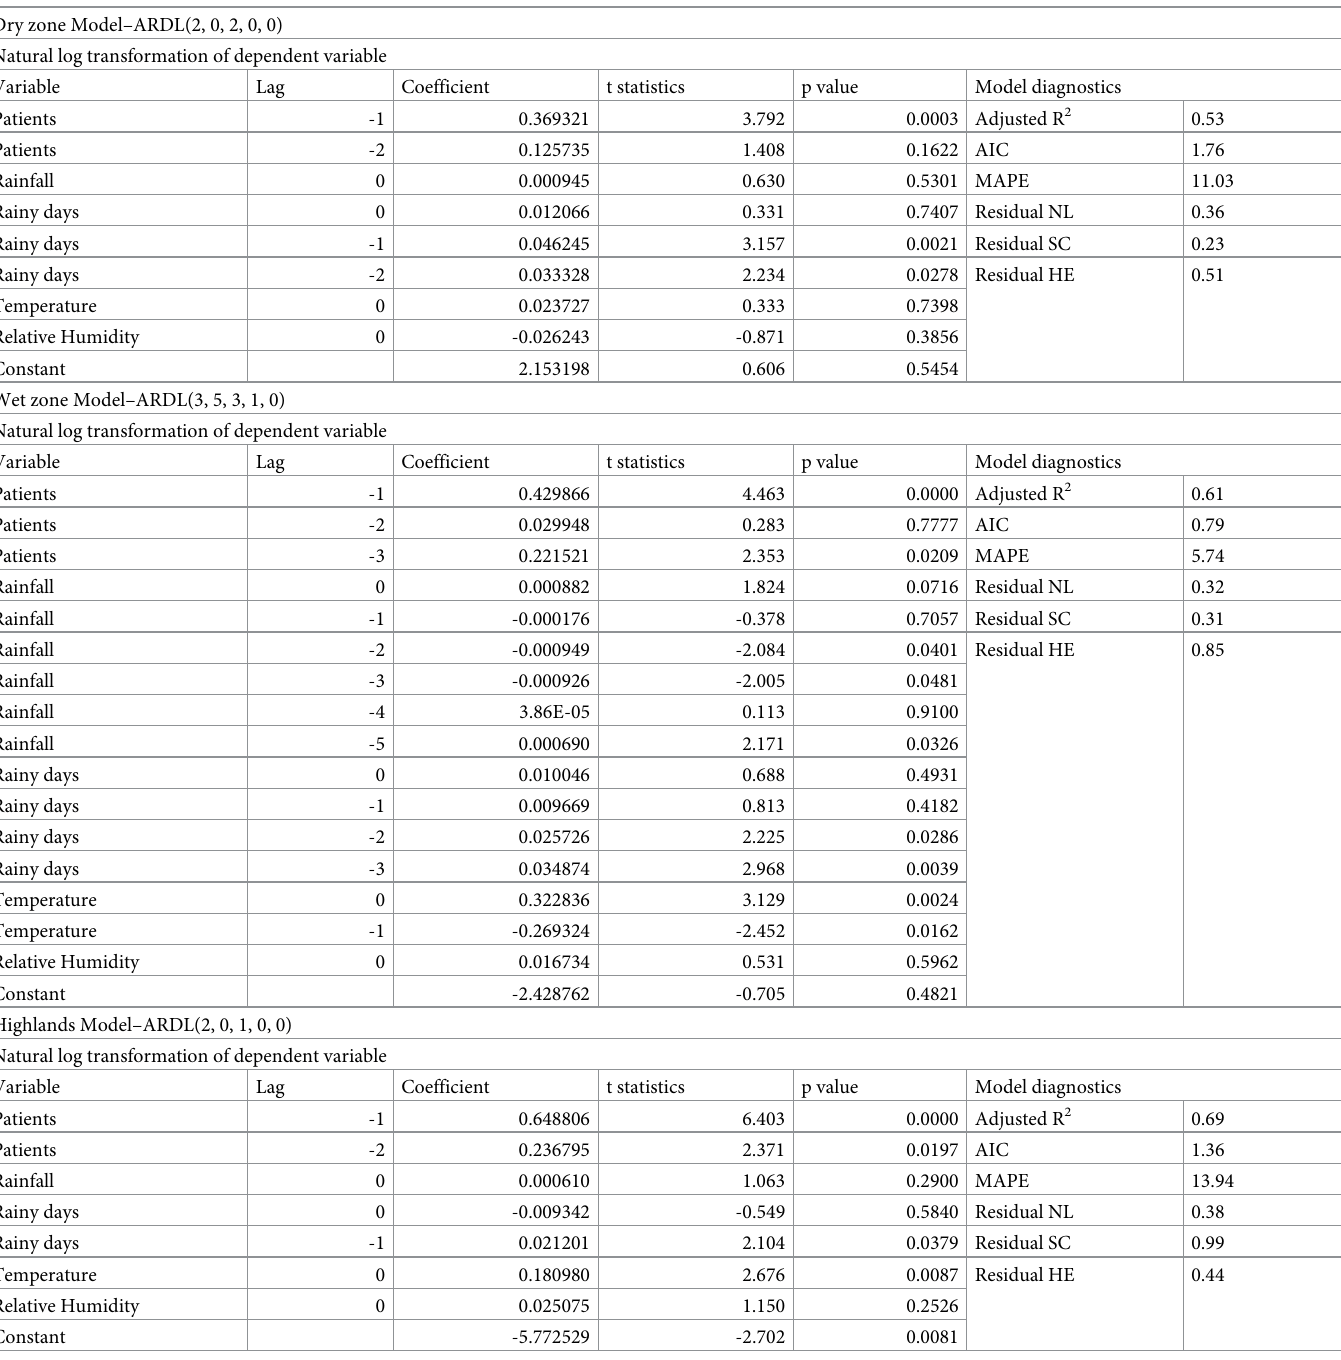
Table 7. Multivariable ARDL models for the three climate